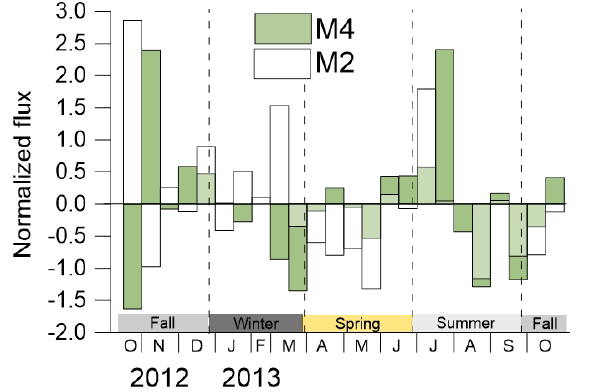
Figure 4. Deviation from the annual mean coccolith flux deter- mined for trap stations M4 (green) and M2 (transparent